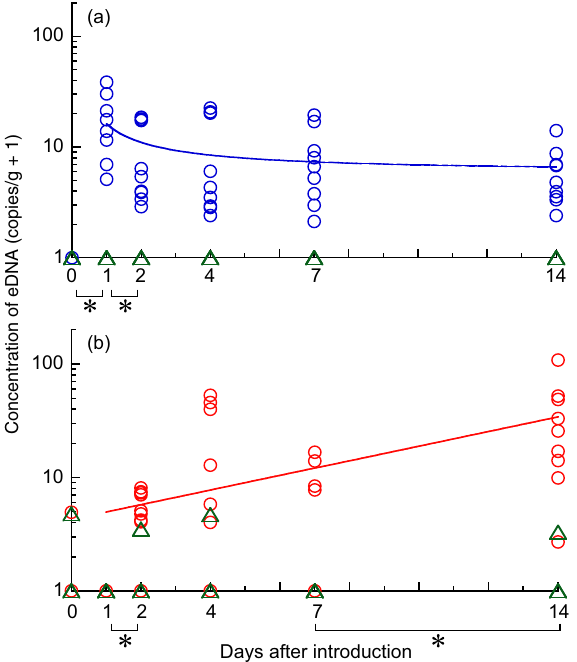
Figure 3. Concentration of eDNA in ( a ) tank water and ( b ) sediment after the introduction of fish. Nine samples (triplicates from each of three tanks, indicated by circles) for test groups and three samples (triplicates from one tank, triangles) for control were analyzed and plotted. Asterisks indicate significant differences between two consecutive sampling days ( p < 0.05, Tukey’s HSD test). The best models shown in Supplementary Table S3 were